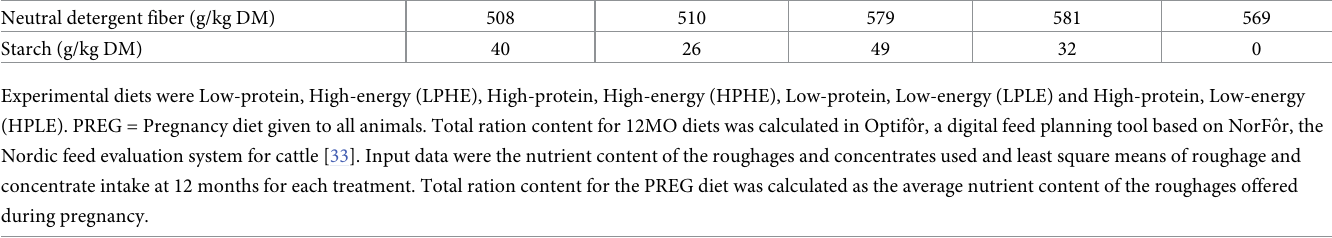
Table 1. Average nutrient content of experimental diets at 12 months and common diet offered during pregnancy.